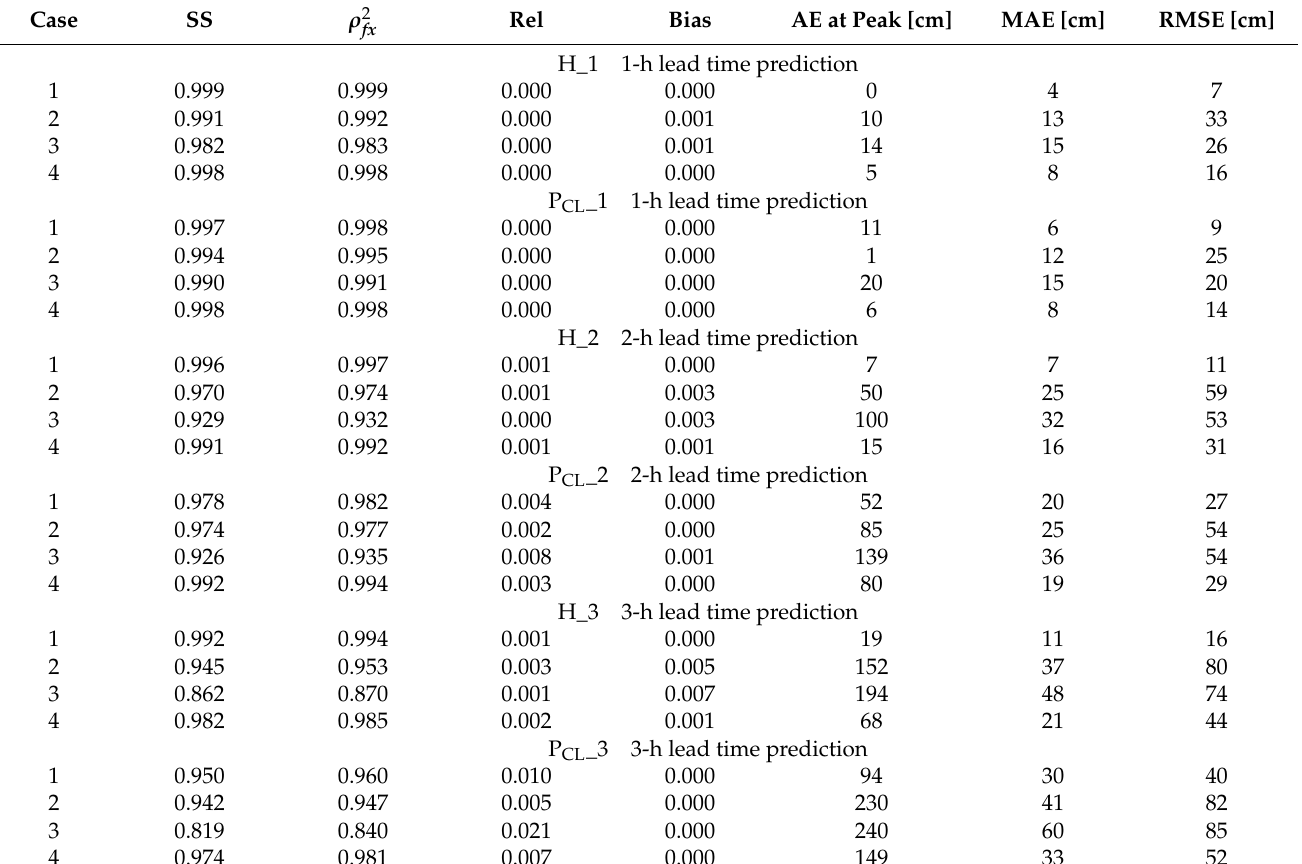
Table 5. Same as Table 2 except for this is for H_ t and P CL _ t . The lead time is defined with respect to the latest time of stage observation at